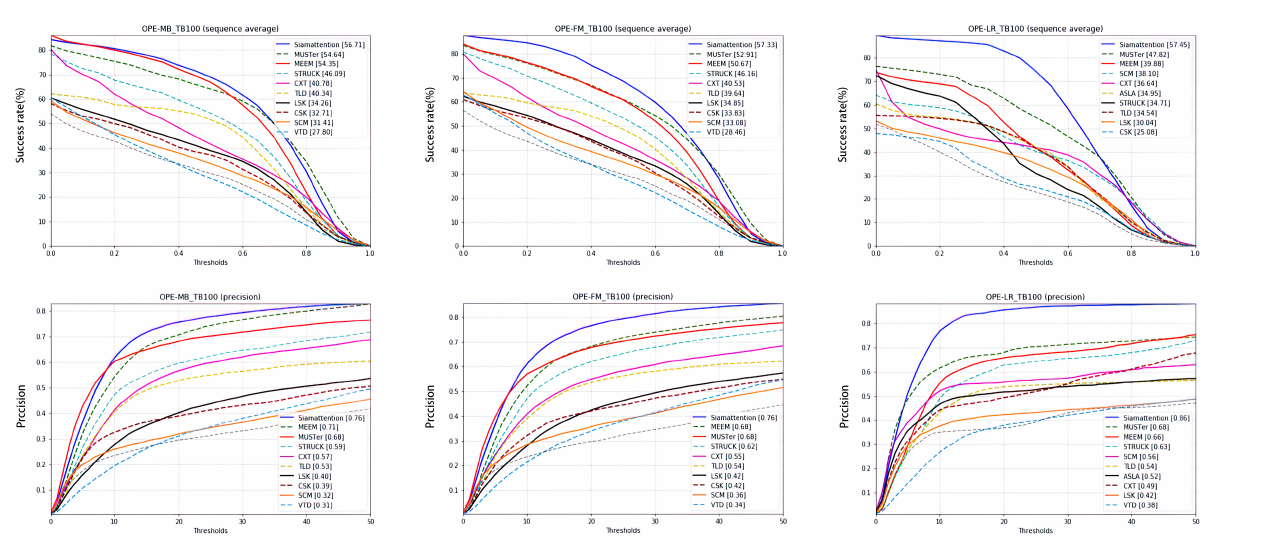
Figure 12. Success plot and precision plot of MB, FM, and LR. The proposed tracker is shown as the solid blue lines, ranking first in all